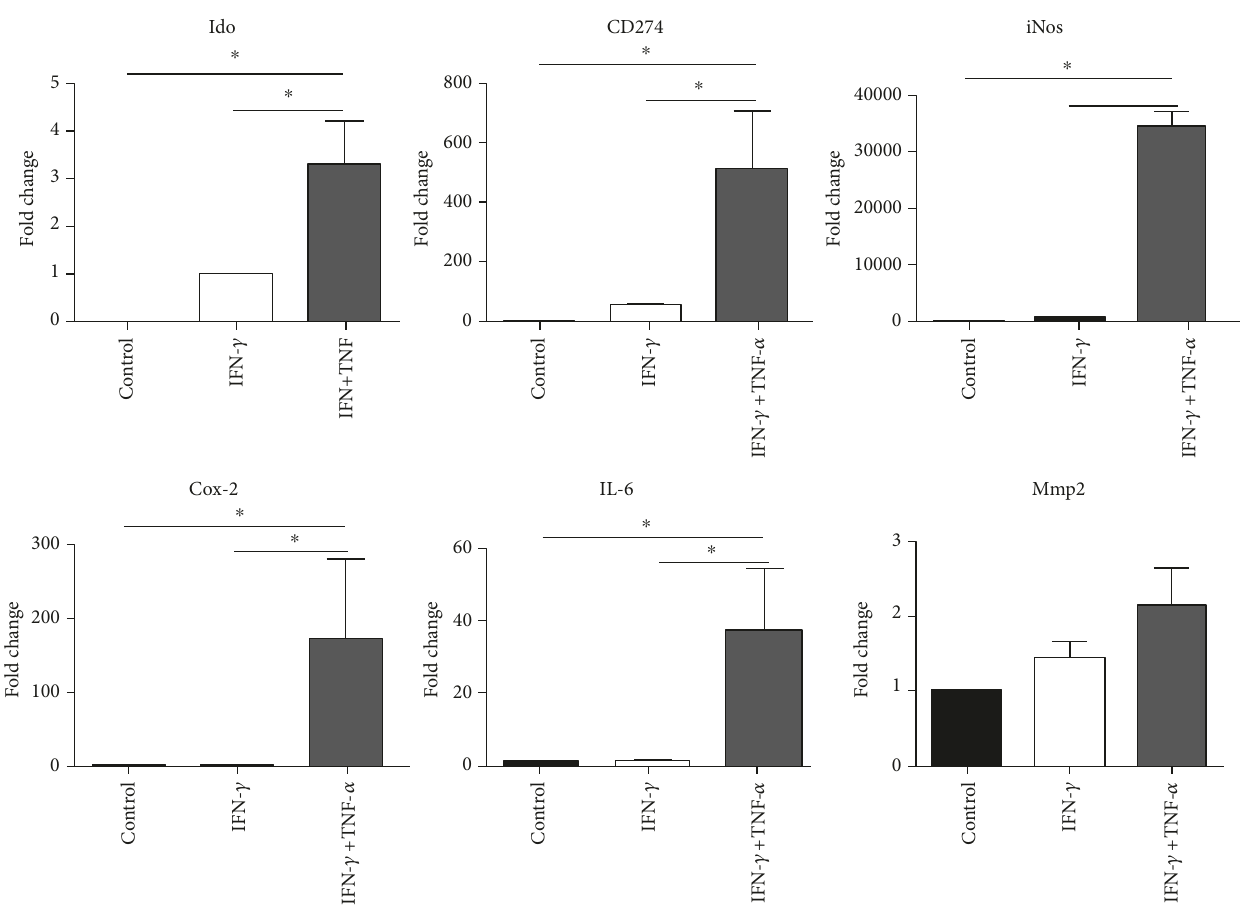
Figure 1: Increased expression of anti-in fl ammatory genes in preactivated mesenchymal stem cells. Gene expression analysis of murine MSCs was performed after preactivation with 20 ng/mL IFN- γ and 30 ng/mL TNF- α for 20 h. Expression changes on Il-6, Pd-l1 (CD274), iNos, Ido, Cox-2, and Mmp2 were analyzed by qPCR on preactivated cells and compared to the control group (untreated cells). Data were expressed as fold change ± SD of three independent experiments. ∗ P < 0 05 . One-way ANOVA, post hoc